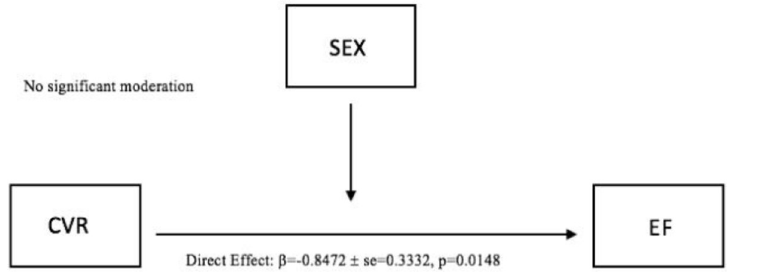
Fig 5. Moderation model (CVR � SEX) on